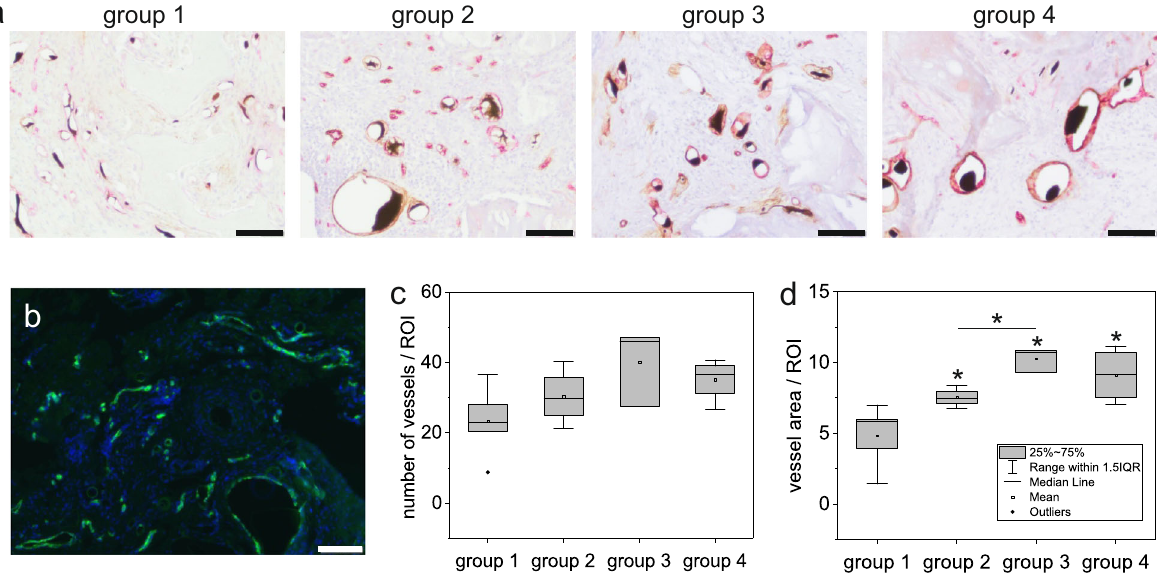
Fig. 5 Histological quanti fi cation of vascularization. a Double-staining α -SMA (brown) and vWF (red). b CD31 immuno fl uorescence staining of bone defects (representative image of group 1). c Number of vessels and d vessel area were calculated per ROI (y-axis) in the different experimental groups (x-axis). Scale bars 100 µm. * p < 0.05 (Kruskal – Wallis test/Mann – Whitney U